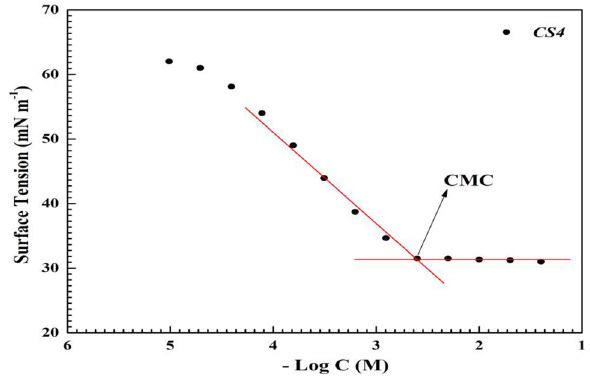
Figure 3. Surface tension Vs concentration of CS4 in 1 M HCl at room temperature.